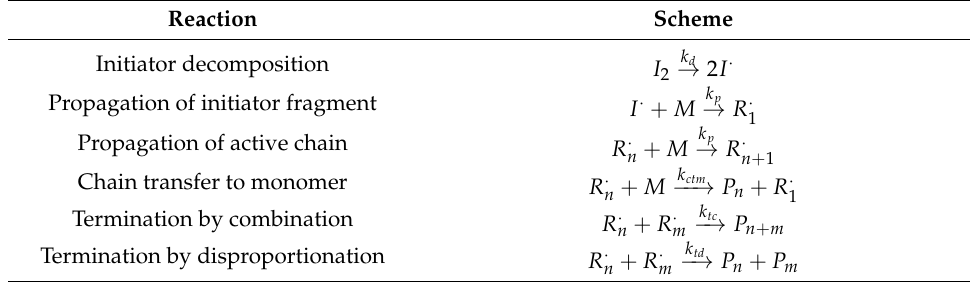
Table 1. Reaction scheme used in the modeling of non-ionized methacrylic acid (MAA) polymerization.